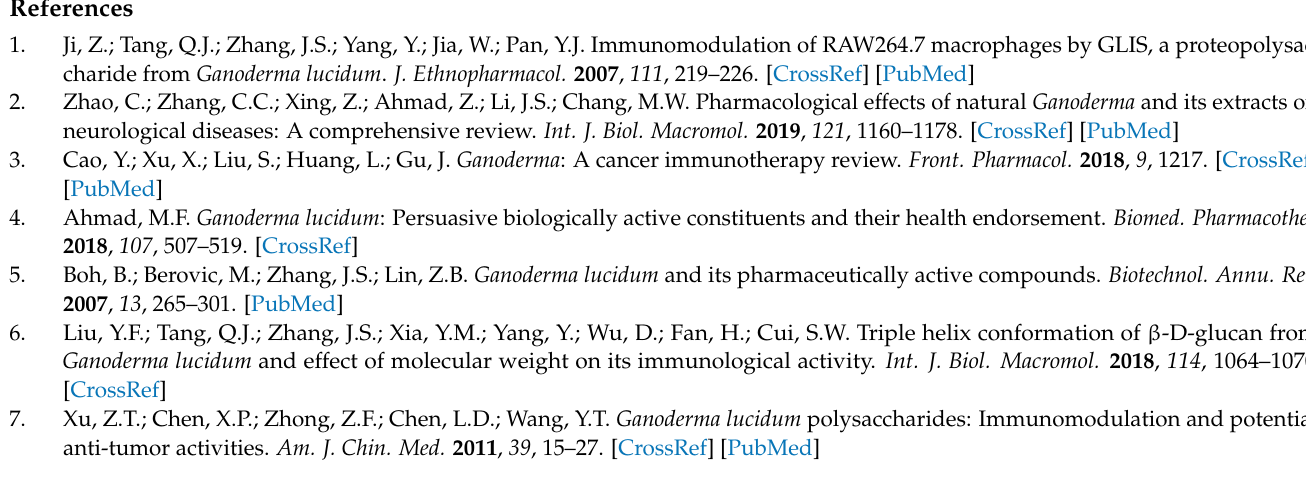
charide composition profile; Table S2: The percentage of common peak areas in the PMP–HPLC fingerprint; Table S3: The correlation coefficient of 14 common peaks based on PLSR; Table S4: The VIP values of 14 common peaks based on PLSR; Figure S1: The scatter plot of NO production and